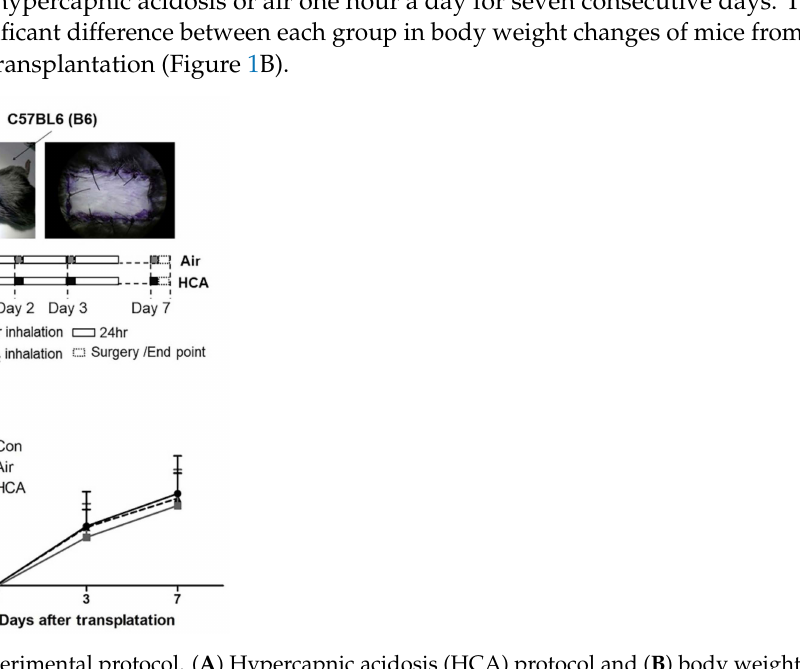
Figure 1. Experimental protocol. ( A ) Hypercapnic acidosis (HCA) protocol and ( B ) body weight gain in mice after